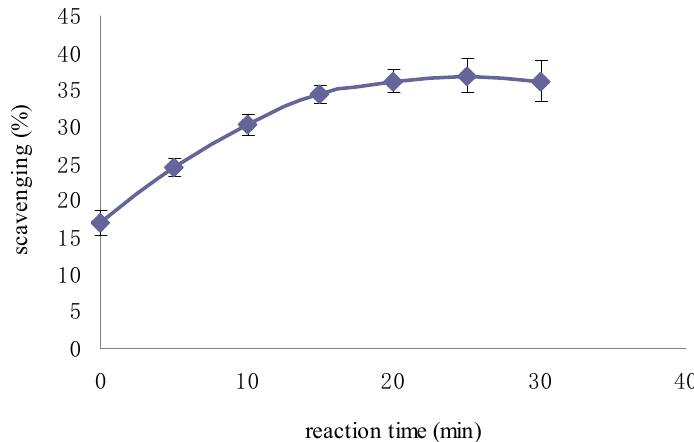
Figure 4. Percent scavenging of DPPH by Fuco over